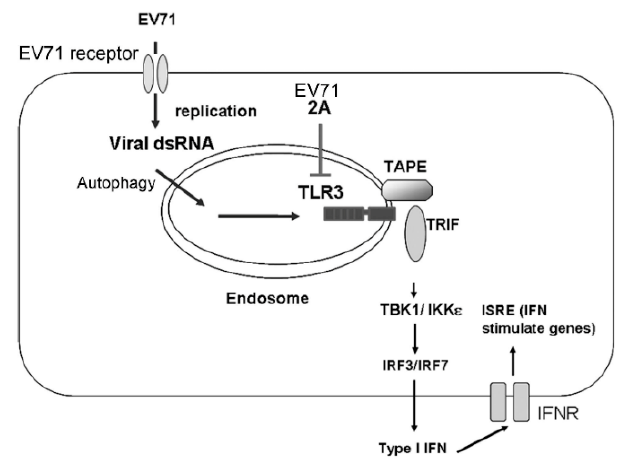
Figure 7. A model for the detection of EV-A71 infection by TLR3. Upon infection into host cells, EV-A71 generates dsRNA during viral replication. Endosomal TLR3 in host cells detects EV-A71 dsRNA, possibly via autophagy, to recruit the adaptor TRIF and TAPE, which further trigger signaling pathways to IFN- β activation and subsequent expression of IFN-stimulated genes (ISGs). To promote EV-A71 survival in host cells, EV-A71 uses its 2A protease to target TLR3 for degradation to counteract type I IFN-mediated antiviral responses.